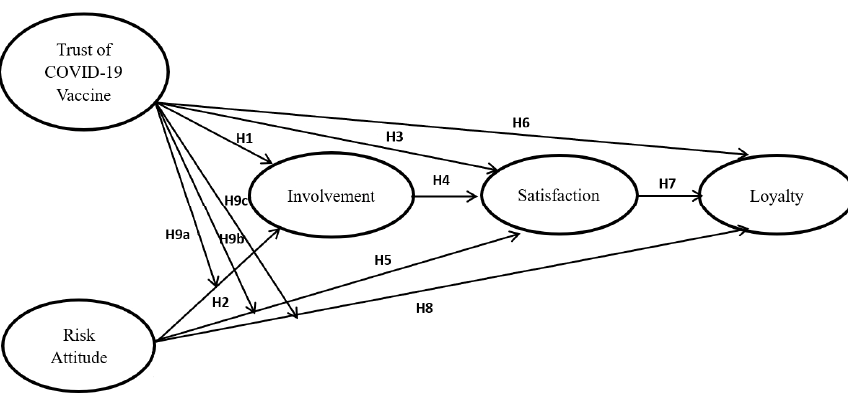
Figure 1. The Research